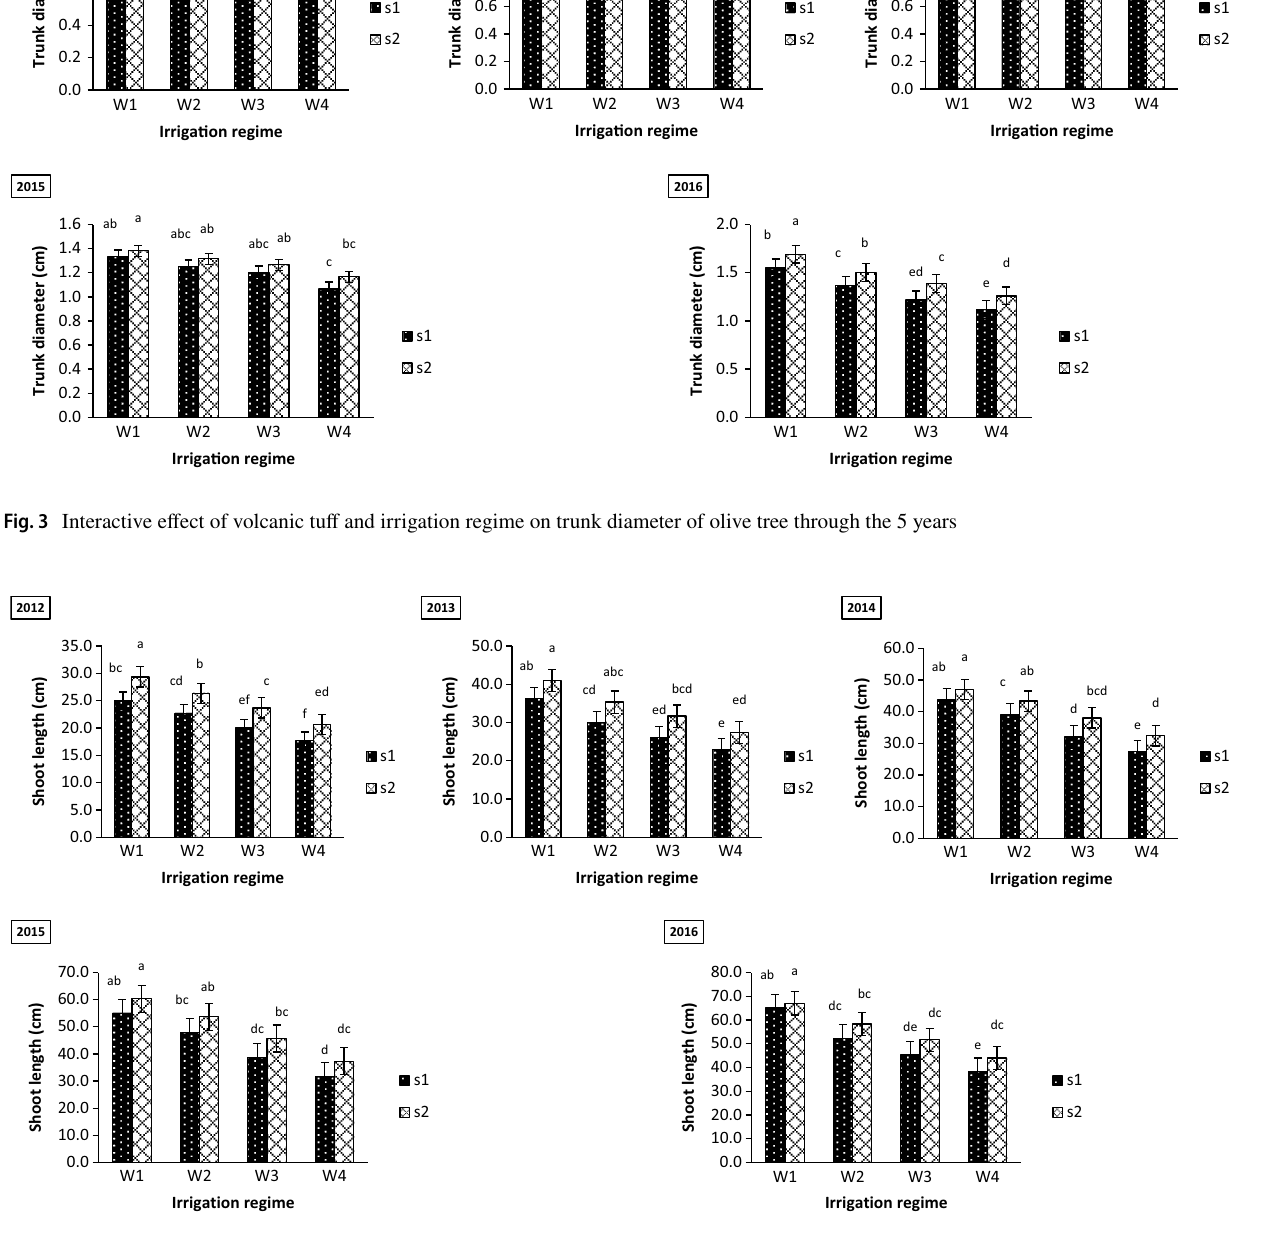
Fig. 4 Interactive effect of volcanic tuff and irrigation regime on shoot length of olive tree through the 5